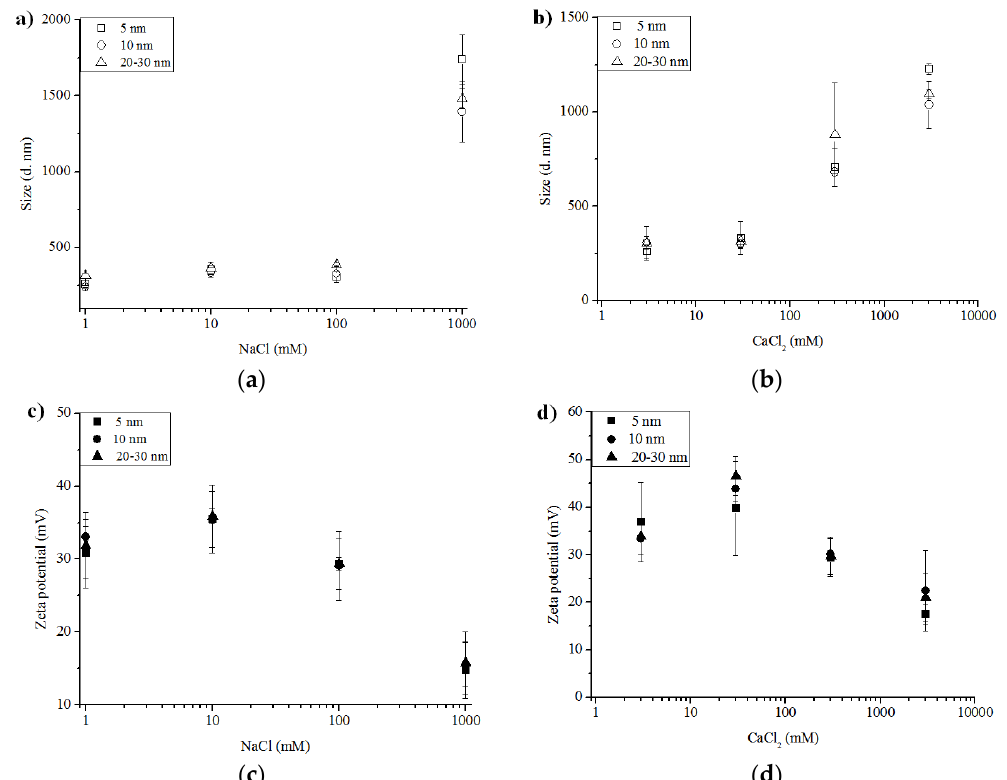
Figure 4. ( a ) Z ave hydrodynamic diameter of 5 nm (□), 10 nm ( ○ ), and 20–30 nm ( △ ) γ-Al 2 O 3 NP aggregates, as a function of ionic strength (NaCl); ( b ) Z ave hydrodynamic diameter of 5 nm (□), 10 nm ( ○ ), and 20–30 nm ( △ ) γ-Al 2 O 3 NP aggregates, as a function of ionic strength (CaCl 2 ); ( c ) ζ potential of 5 nm ( ■ ), 10 nm (●), and 20–30 nm ( ▲ ) γ-Al 2 O 3 NP aggregates, as a function of ionic strength